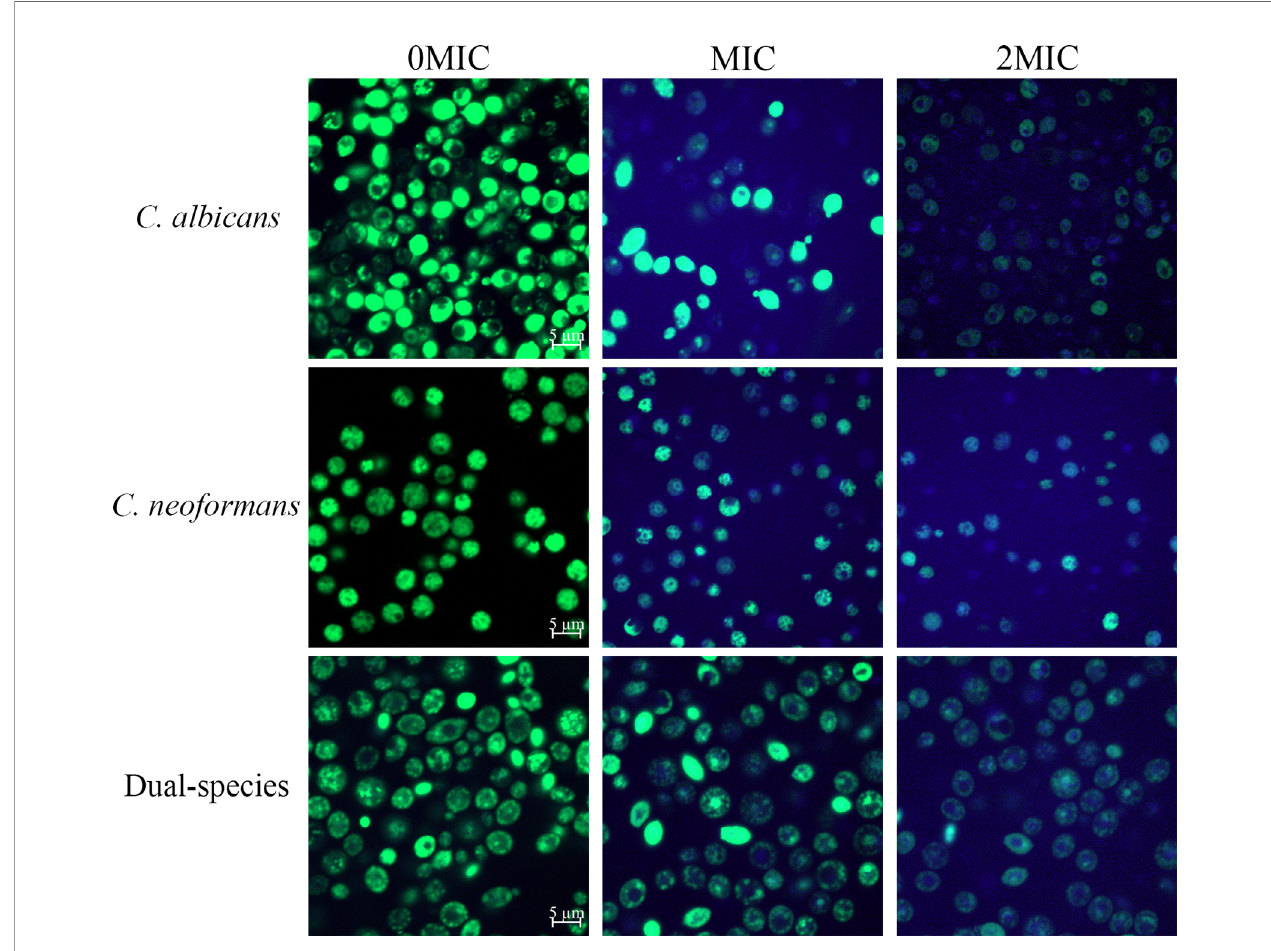
FIGURE 3 | Examination of gati fl oxacin in fl ux to cells of C. albicans SC5314 and C. neoformans H99 mono- and dual-species cultures following exposure to paeonol by confocal laser scanning microscope combined with STYO 9 (green fl uorescent signals) and gati fl oxacin (blue fl uorescent signals) with its intrinsic fl uorescence characteristics. Fluorescent signals were generated in fungal cells cultured in YPD medium supplemented with fi nal concentrations of 0, MIC, and 2 MIC. Scale bars represent 5 m